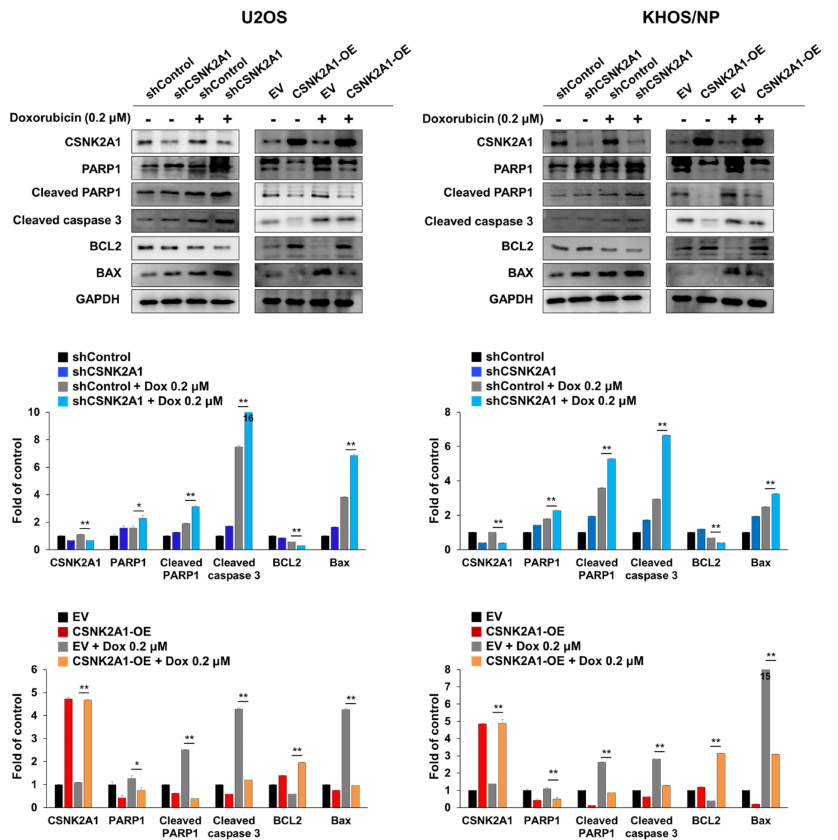
Figure 4. CSNK2A1 involvement in the apoptotic effects of doxorubicin in osteosarcoma cells with western blot analysis. U2OS and KHOS/NP osteosarcoma cells were transfected with control shRNA, shRNA for CSNK2A1, empty vector, or wild-type CSNK2A1 and treated with 0.2 µ M doxorubicin. The expression patterns of CSNK2A1, PARP1, cleaved PARP1, cleaved caspase 3, BCL2, BAX, and GAPDH were determined via Western blot. The density of the Western blot bands was measured in triplicate by using ImageJ software. *; p < 0.05, **; p <